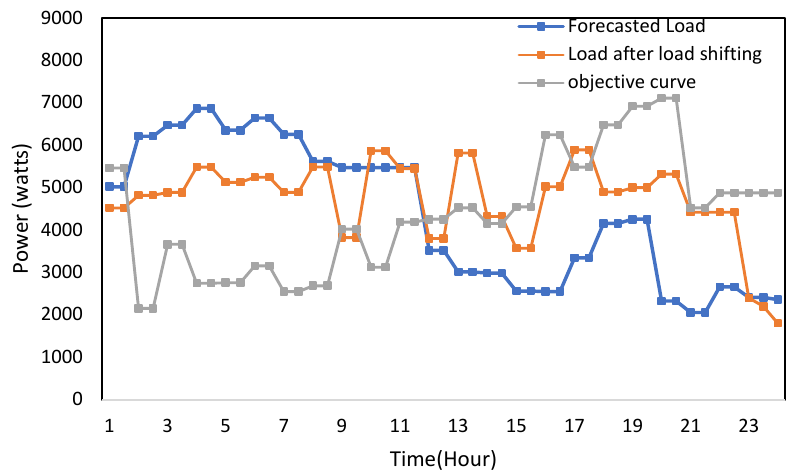
Figure 25. DSM results of industrial load under winter conditions.